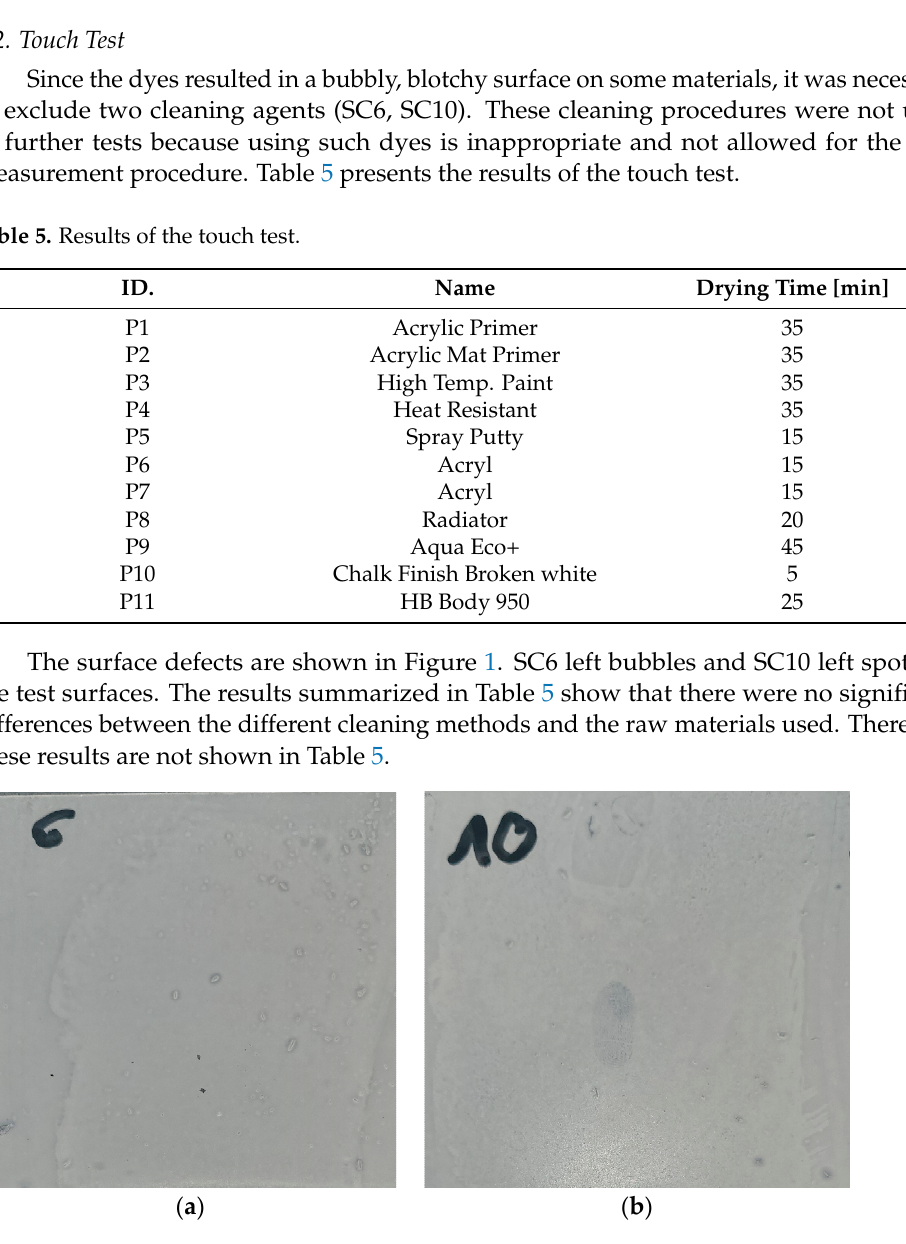
Figure 1. Photos of consequences of inadequate procedures. ( a ) SC6 left bubbles on the test surface; ( b ) SC10 left spots on the test surface. ( b ) SC10 left spots on the test